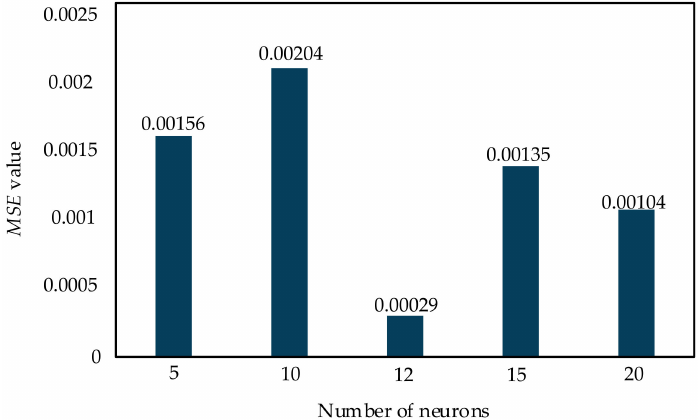
Figure 7. MSE values of phase location under different neurons